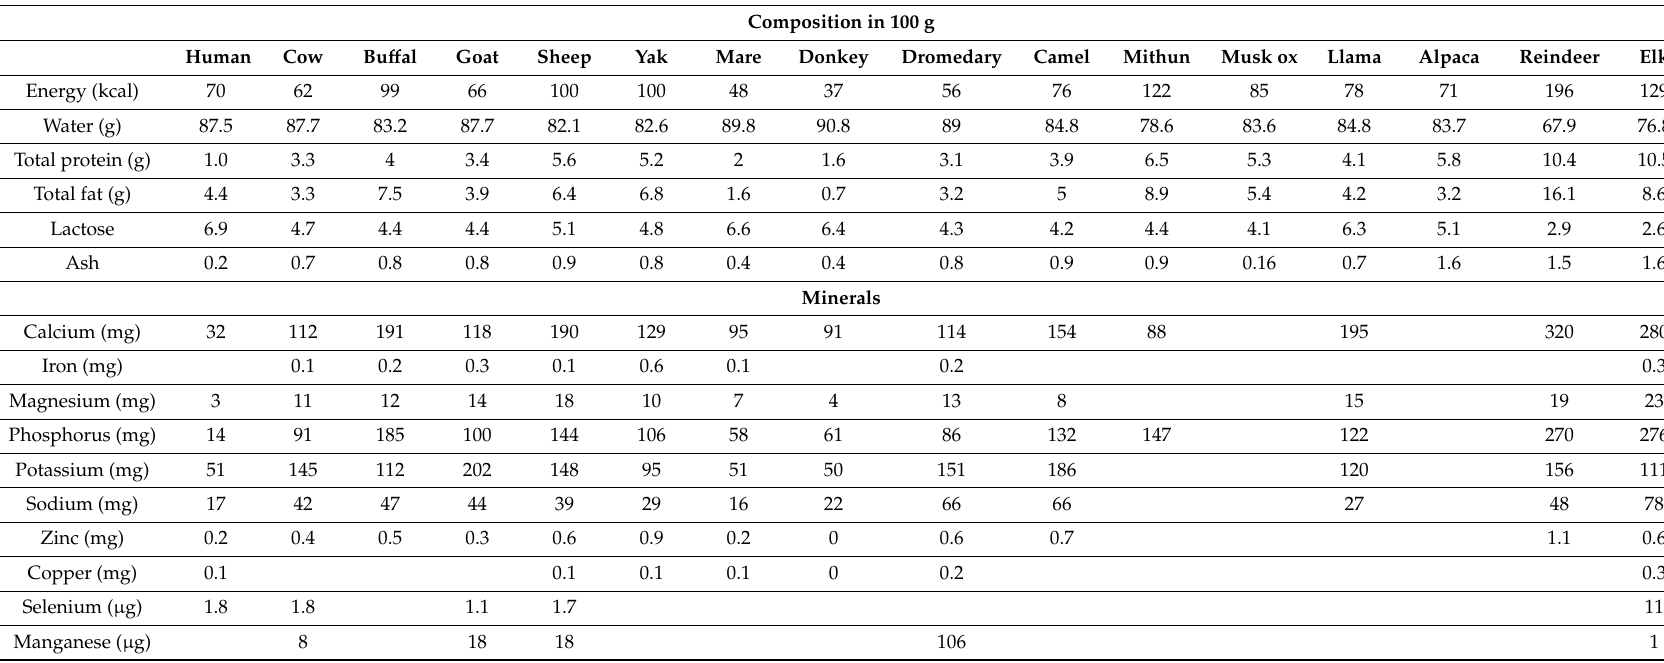
Table 1. Nutritional composition of di ff erent types of milk of animal origin. Source: Food and Agriculture Organisation of the United Nations (FAO)